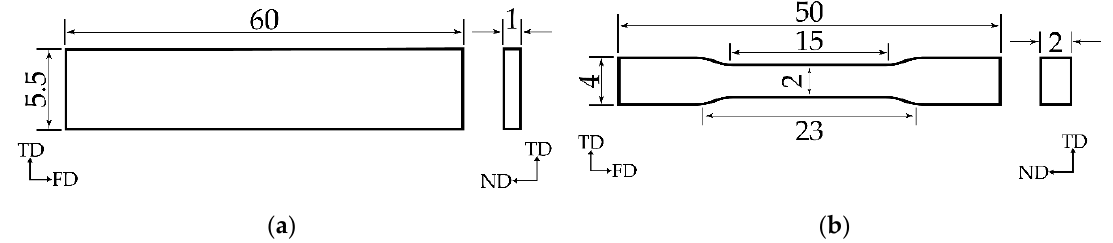
Figure 1. Dimensional samples (unit: mm): ( a ) sheet sample; ( b ) dumbbell sample.